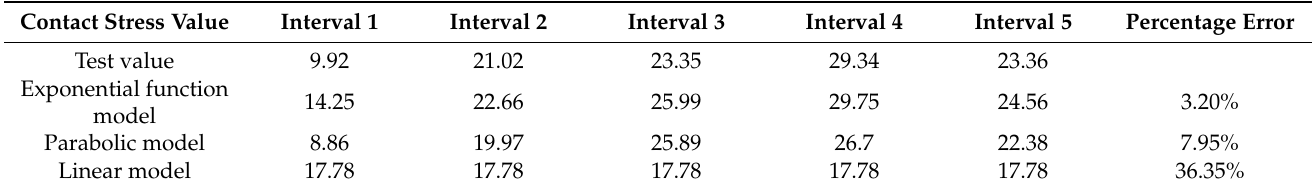
Table 4. Error comparison between different models and experimental stress values (N/cm 2 ) ( λ = 9.375).